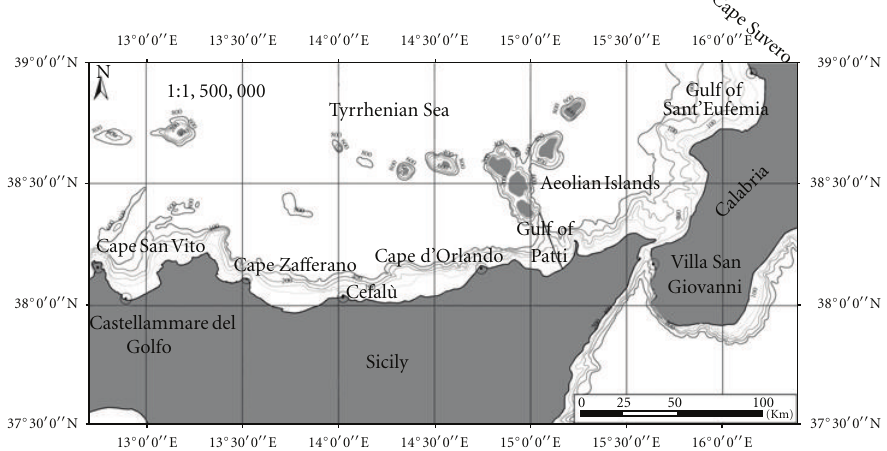
Figure 1: Sampling